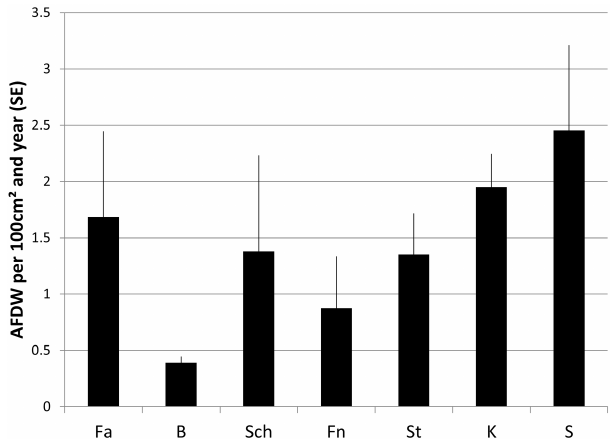
Fig. 7. Mean yearly productivity at the various stations expressed as ash free dry weight (AFDW) accrual per 100cm 2 and